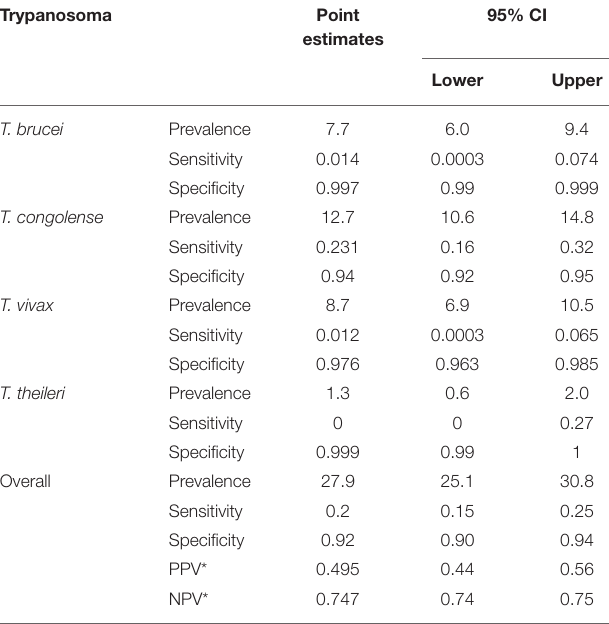
TABLE 3 | Prevalence of Trypanosome species in naturally infected cattle in Lambwe valley, and the sensitivity and specificity of BCT, using PCR-HRM as a reference